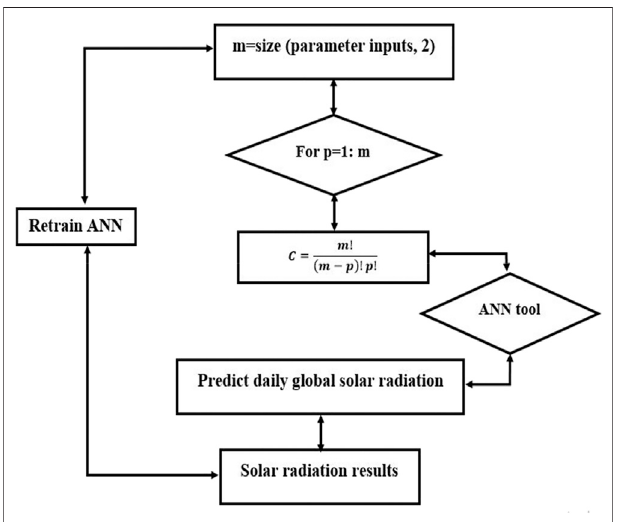
FIGURE 6 | The proposed methodology adopted.